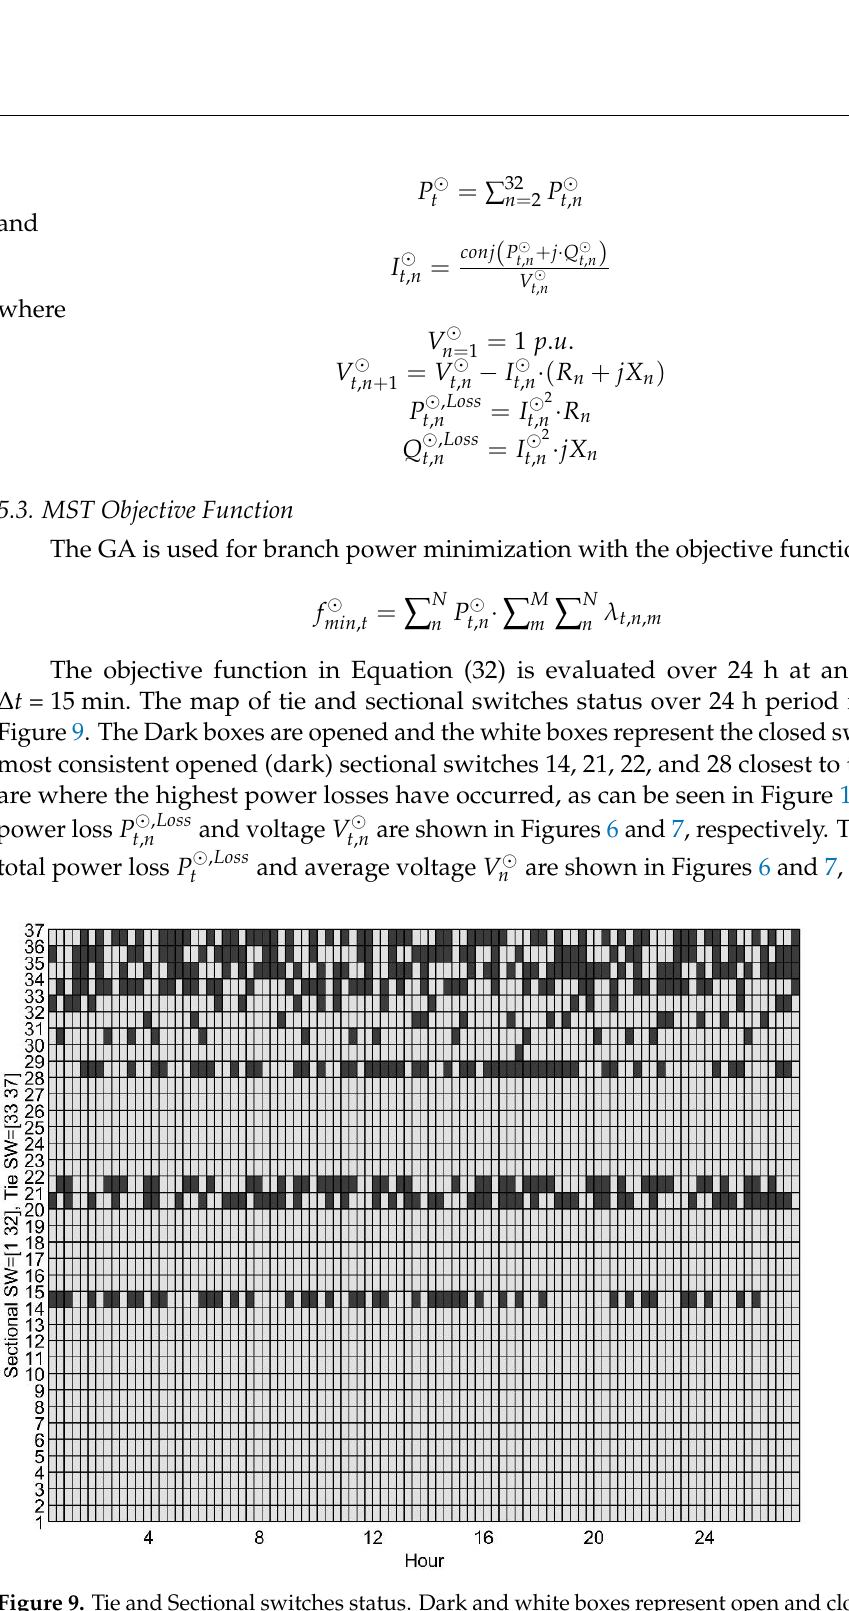
Figure 9. Tie and Sectional switches status. Dark and white boxes represent open and closed switches, respectively.